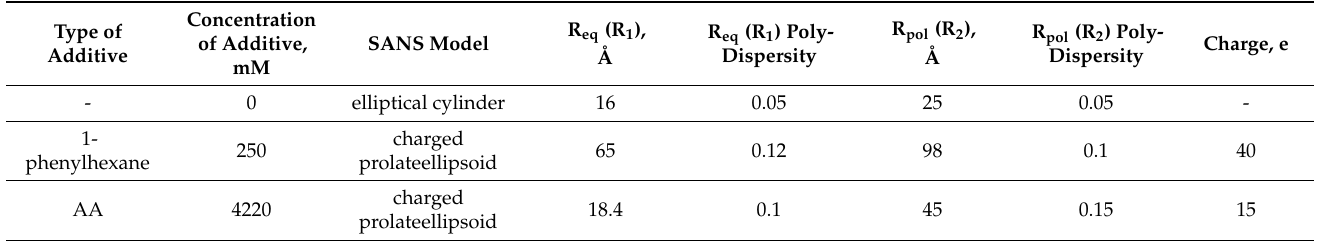
Table 2. Fitting parameters of SANS curves obtained from aqueous solutions containing 78 mM potassium oleate, 117 mM C8TAB and different additives (Figure